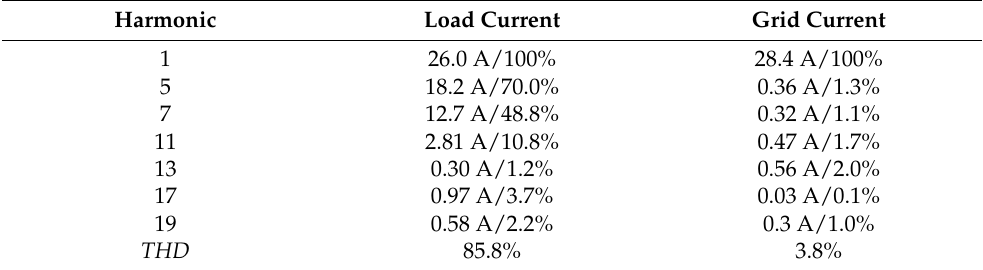
Figure 18. Operation of HAPF with the load Ld1: ( a ) the grid current, the load current and the power converter voltage waveforms; ( b ) harmonic spectrum of the grid and the load currents. Table 3. Comparison of the load currents and the grid currents for HAPF with the load Ld1.